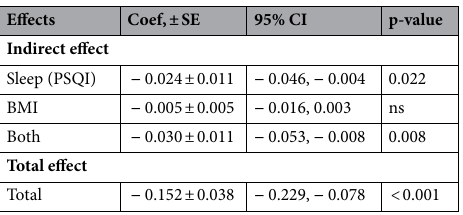
Table 4. Bootstrapping to test indirect and total effects of environmental mastery on blood ceramide levels that were mediated by sleep quality (PSQI) and BMI, separately or